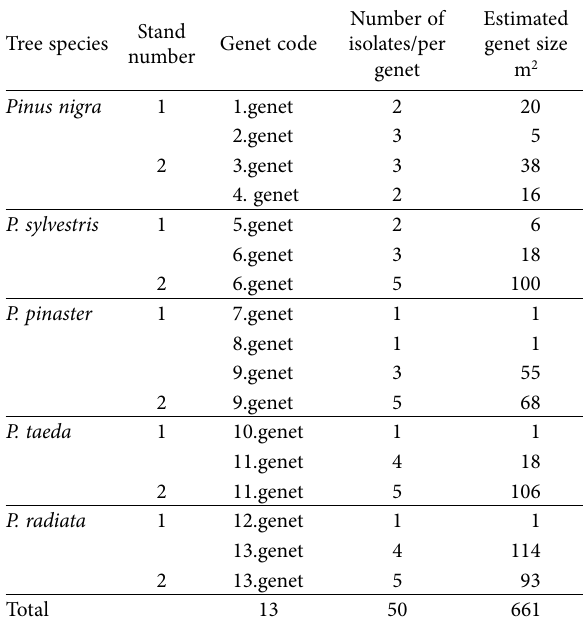
Table 7. Genet size of Diplodia sapinea populations.